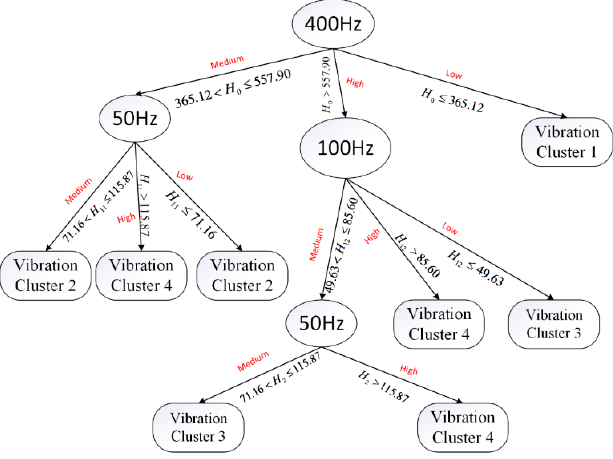
Figure 7. Decision tree of transformer vibration characteristics.